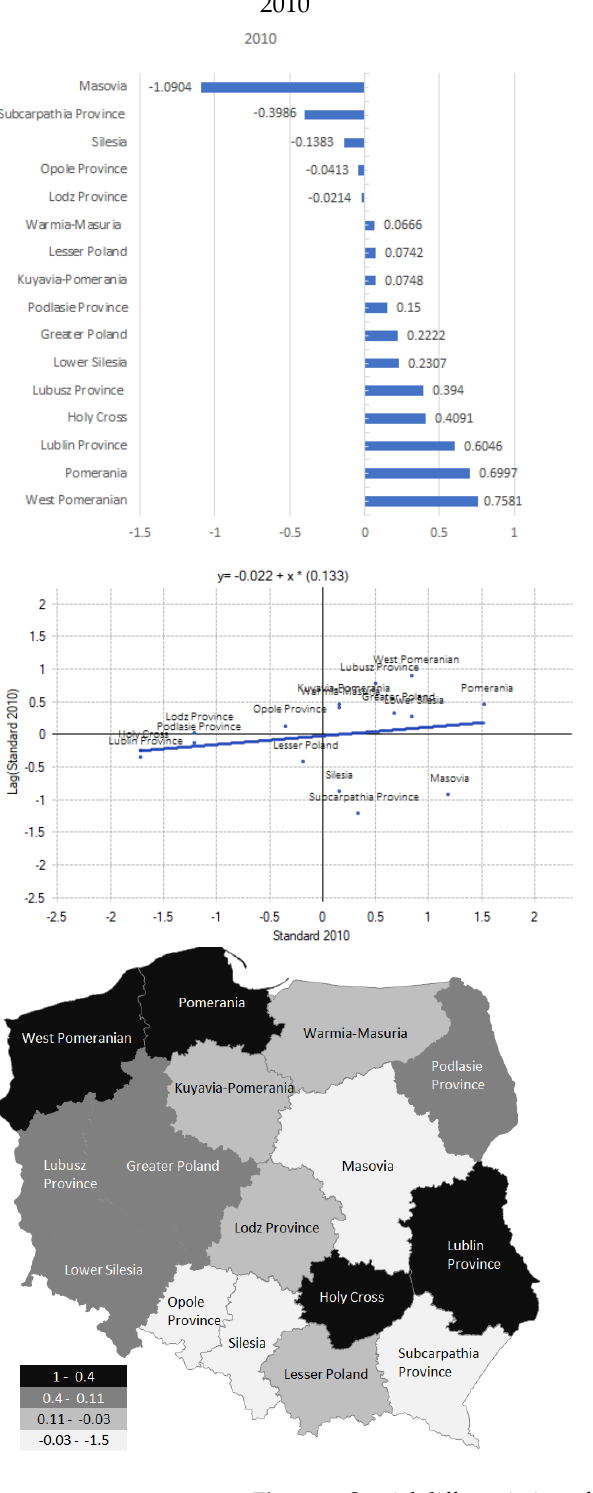
Figure 5. Spatial differentiation of the local value of the Moran I statistics for the synthetic measure of the quality of life in voivodships in Poland (in 2010 and 2020). Source: own study based on the BDL CSO data.